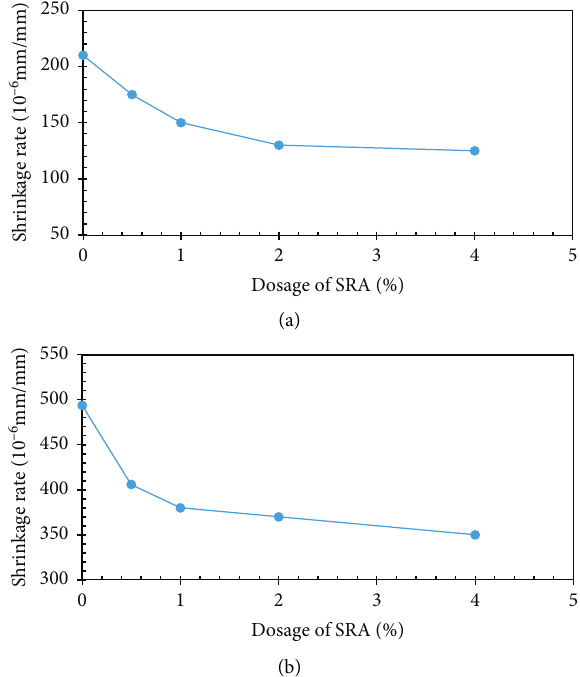
Figure 10: Concrete shrinkage with different doses of SRA (a) at 3 d and (b) 56